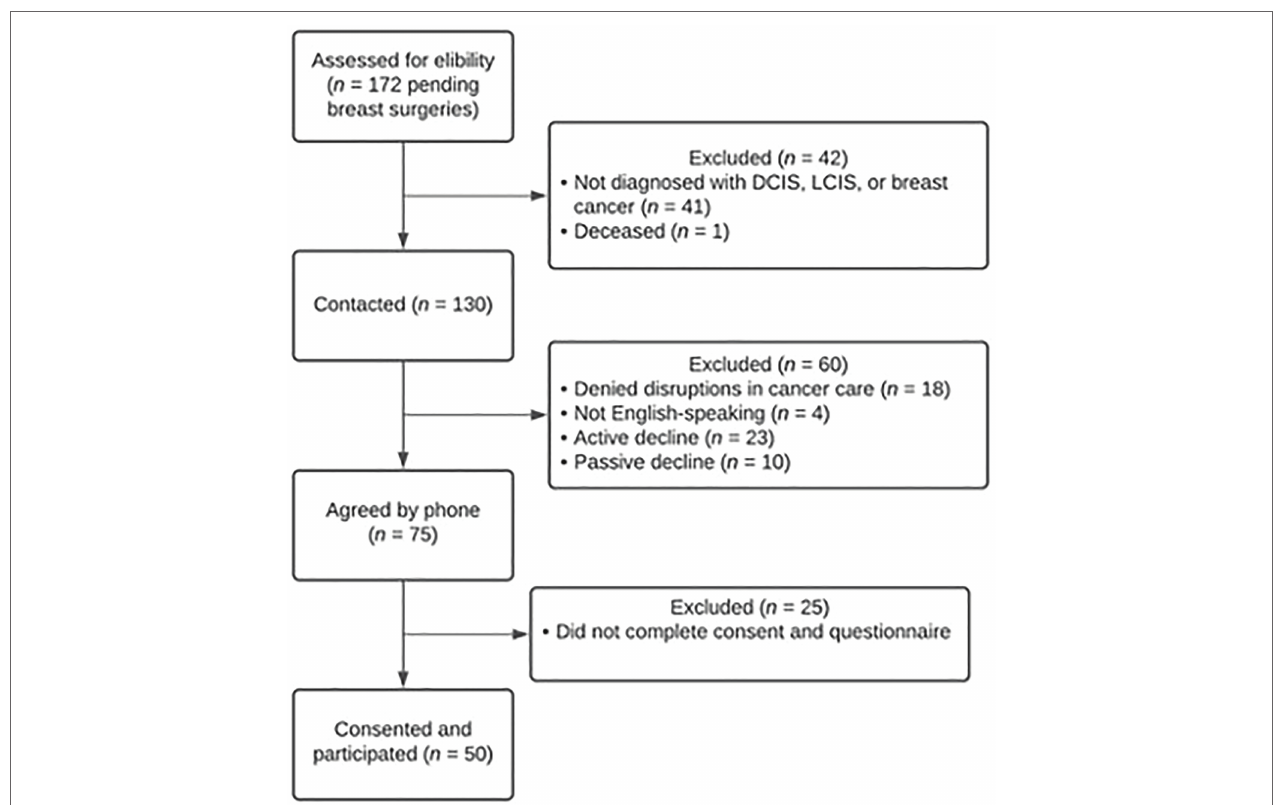
FIGURE 1 | Participant